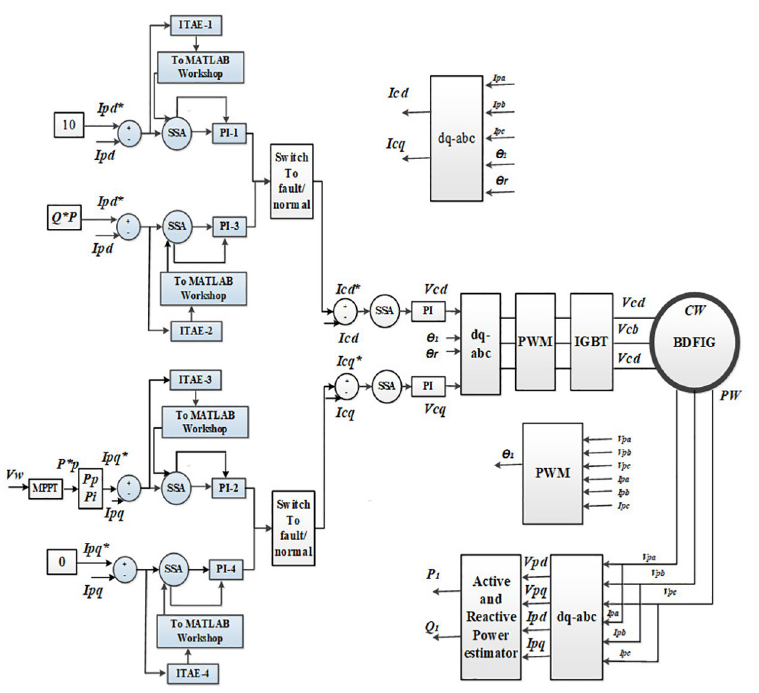
Fig 4. Machine side converter.